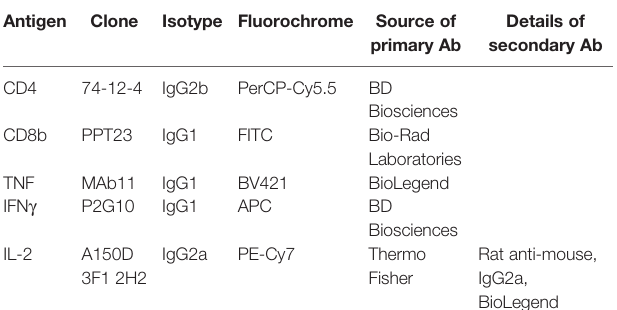
TABLE 1 | Antibodies used for the intracellular cytokine